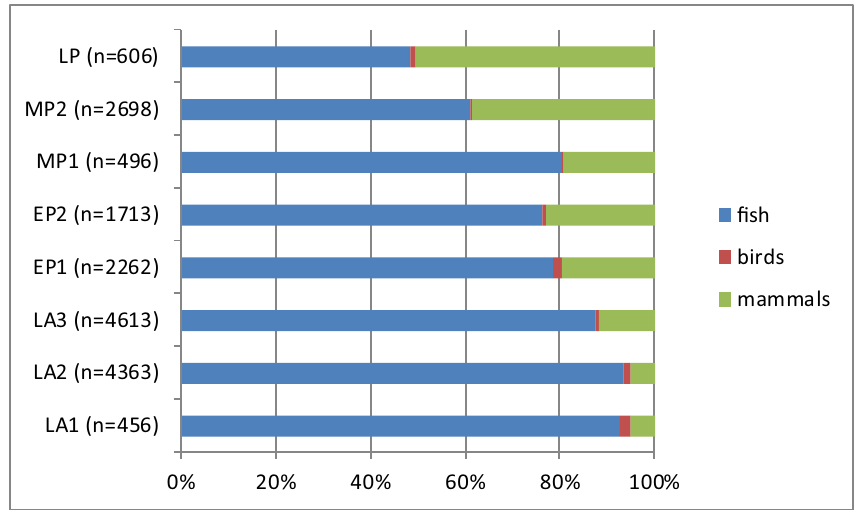
Fig 9. Proportions of the fish, birds and mammals in the various chronological phases. For each period the number of remains (n) is indicated on which the percentages are calculated. The fish bones are all identified specimens, in the case of mammals and birds both identified and unidentified remains are taken into